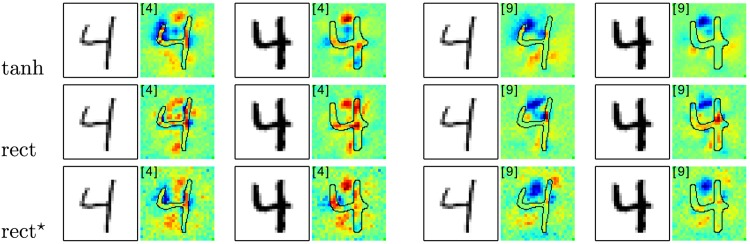
Evidence for a handwritten digit being a “4” or a “9”.Strong positive evidence for “4” is allocated to the top part of the image for keeping it blank. If trying to interpret these digits as “9”, the open top-part of the image is perceived as negative evidence for this class, because a “9” would rather have a top-dash closing the upper loop of the “4”. Explanations are consistent across a variety of neural networks and samples.